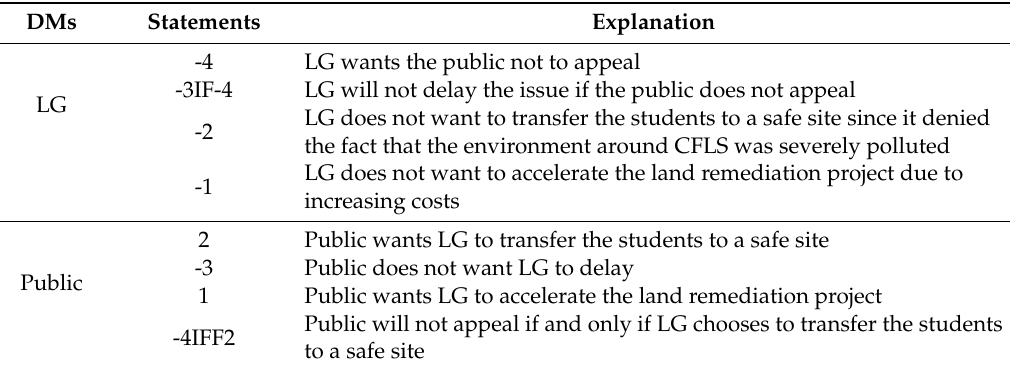
Table 3. Option statements of LG and